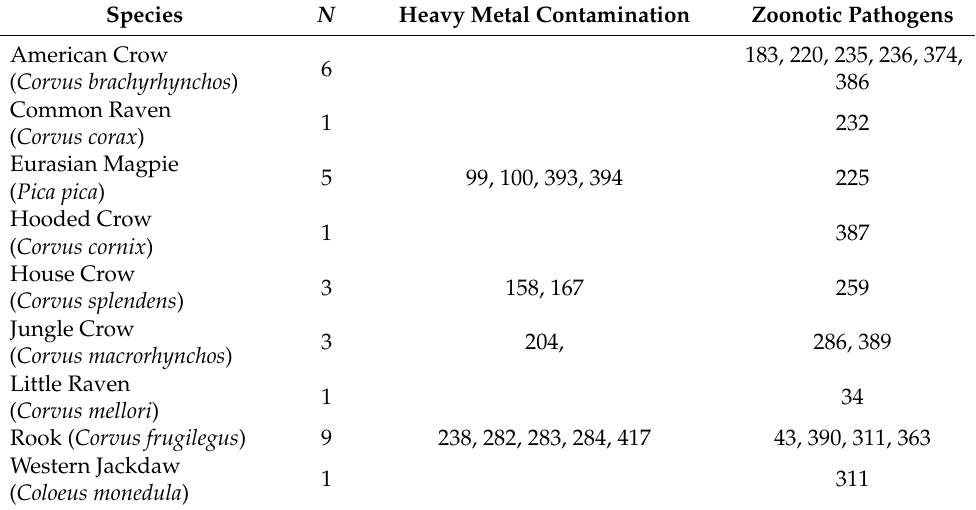
Table 7. List of articles about human-related infection and contaminations of corvids ( n = 29). The reference numbers in the table refers to the individual publication numbers given in Table S2.